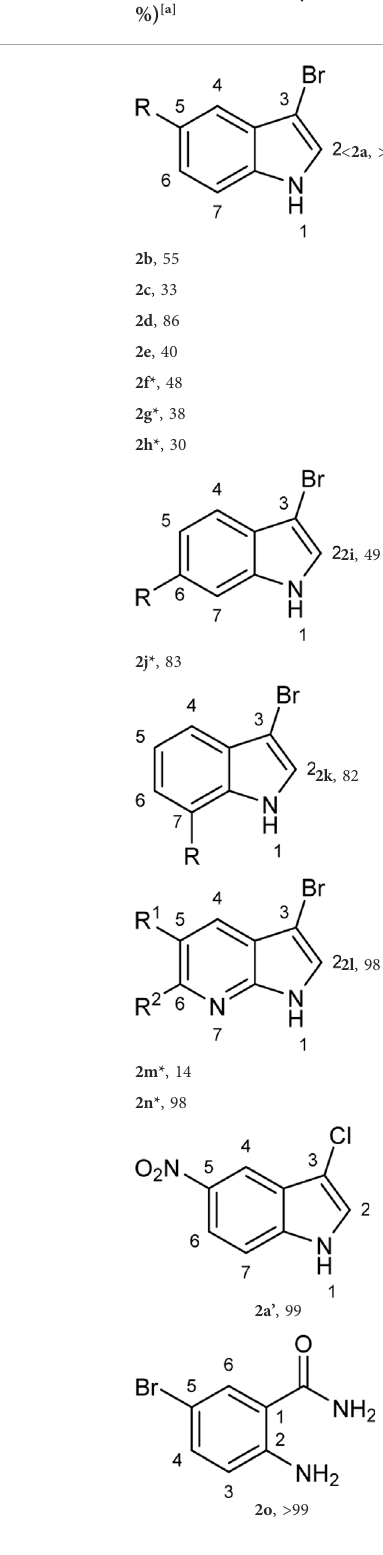
TABLE 3 Halogenation of indoles and other substrates by partially puri fi ed 3-LSR. Entry